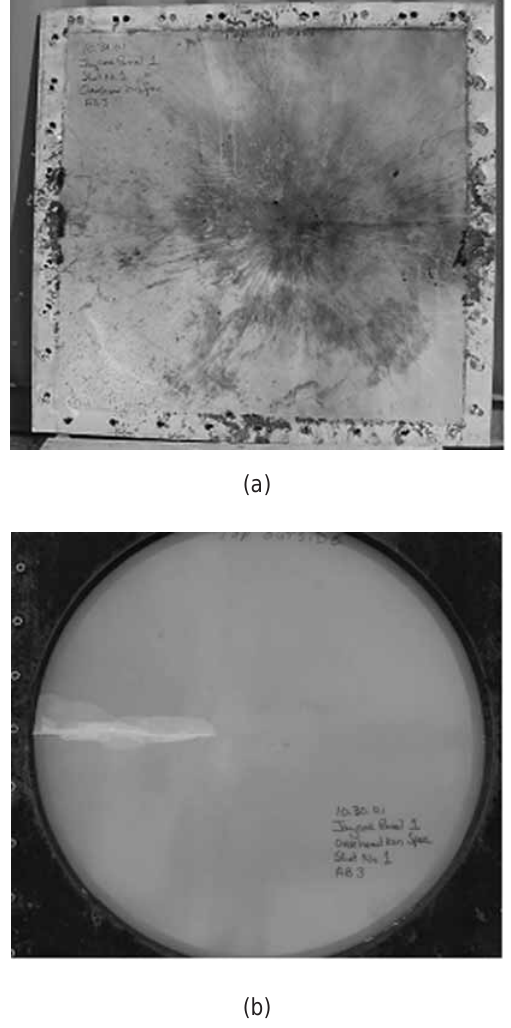
Fig. 4. Panel 1 after shock holing test. (a) Inside view; (b) Outside